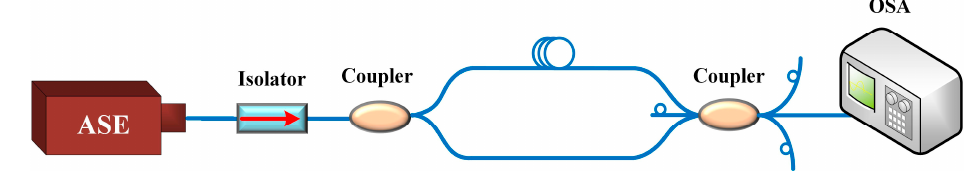
Figure A1. Optical fiber interferometer arm length difference measurement.